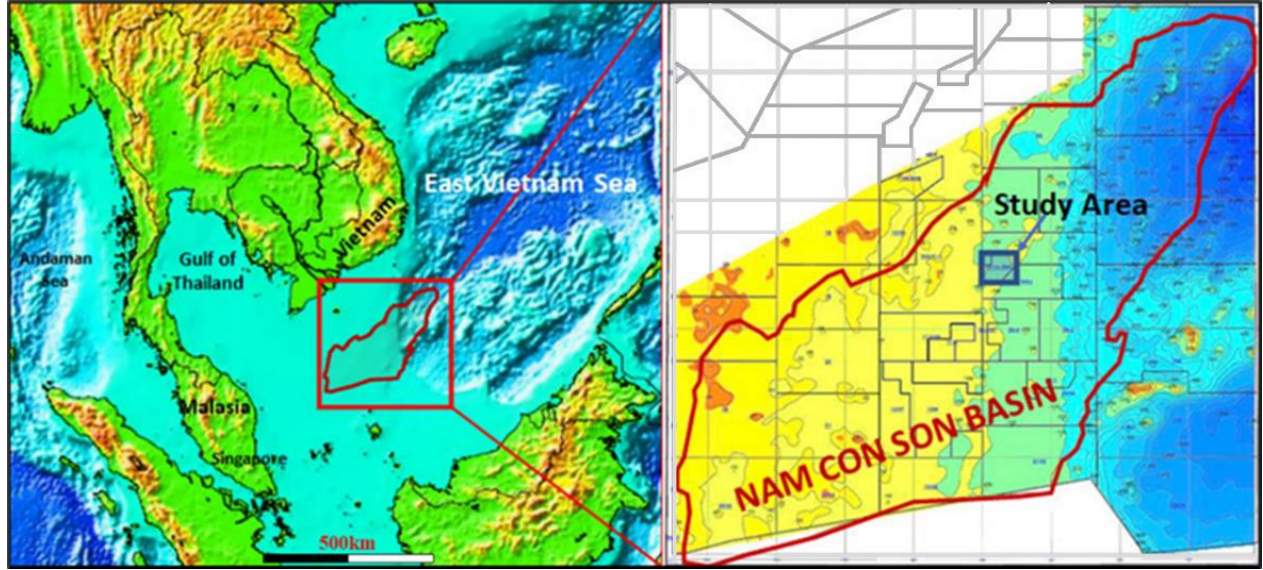
Figure 1. Location map of the Nam Con Son Basin and study area.